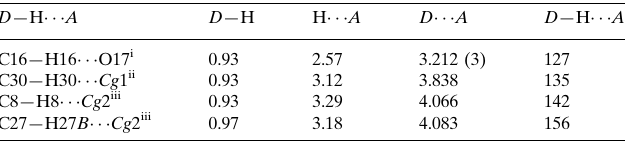
Hydrogen-bond geometry (A˚ , (cid:2)